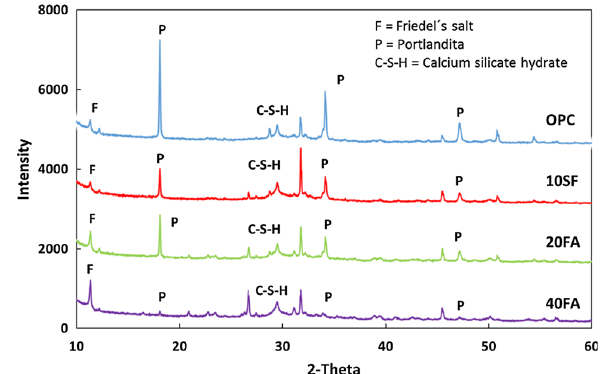
Fig. 2 Chloride concentrations of NaCl external solutions as a function of time.